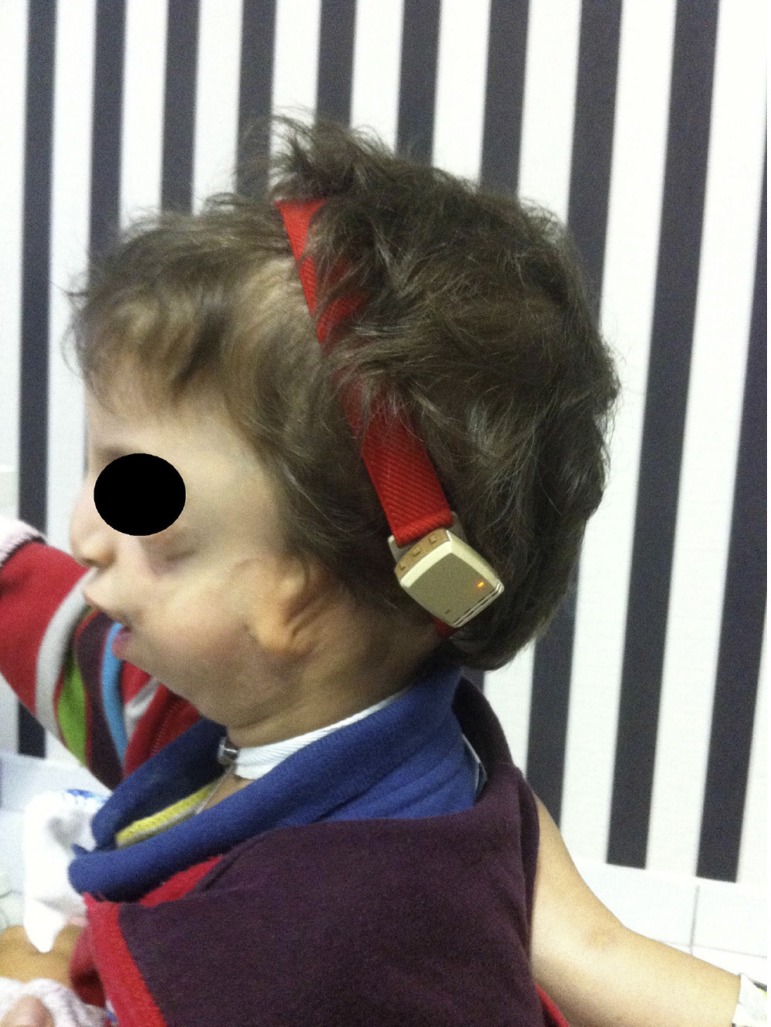
Blepharoplasties.